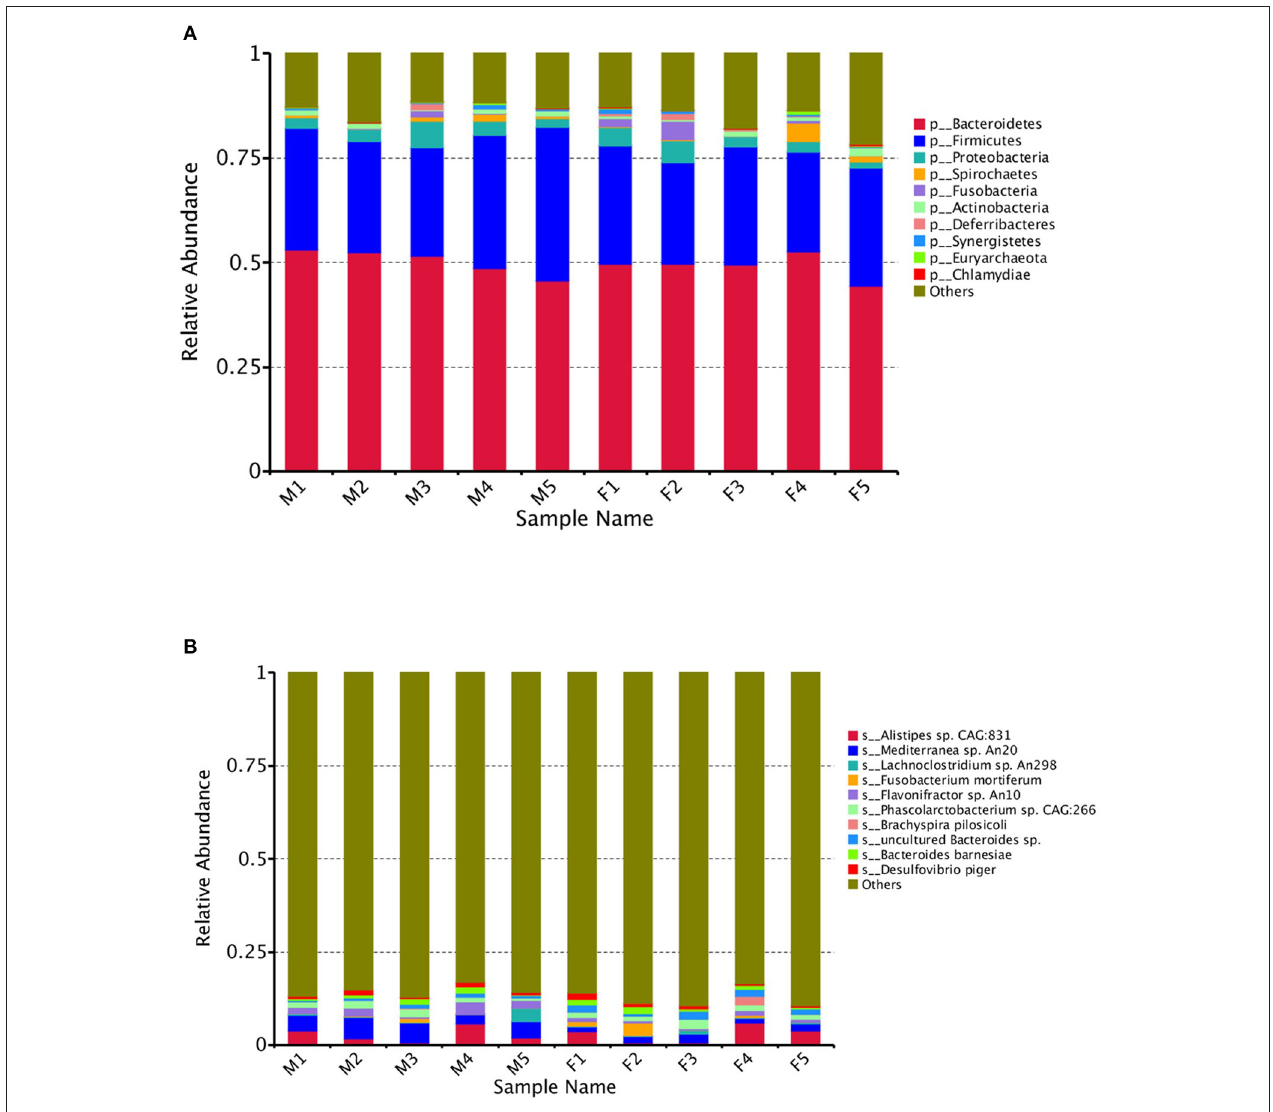
FIGURE 1 | The dominant microbial species in female (F) and male (M) Japanese quail ( Coturnix japonica ) at the phylum (A) and species (B)